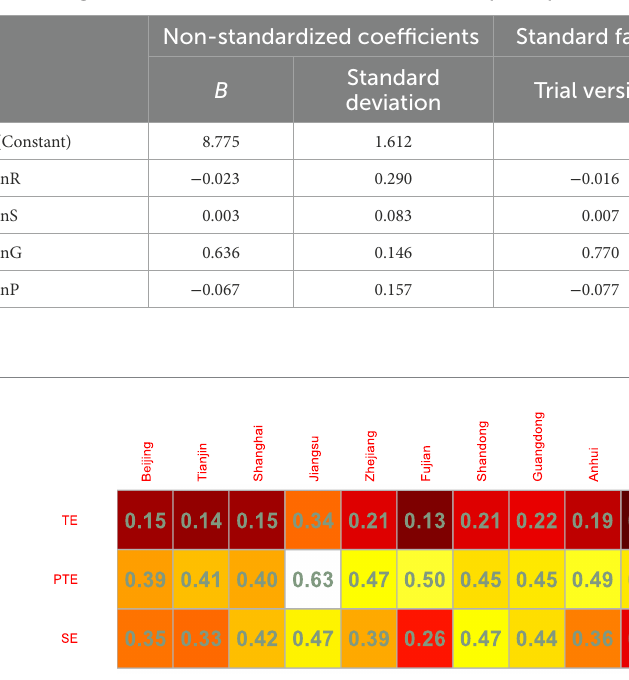
TABLE 3 Regression coefficients and test results of the development path of strategic emerging industries.